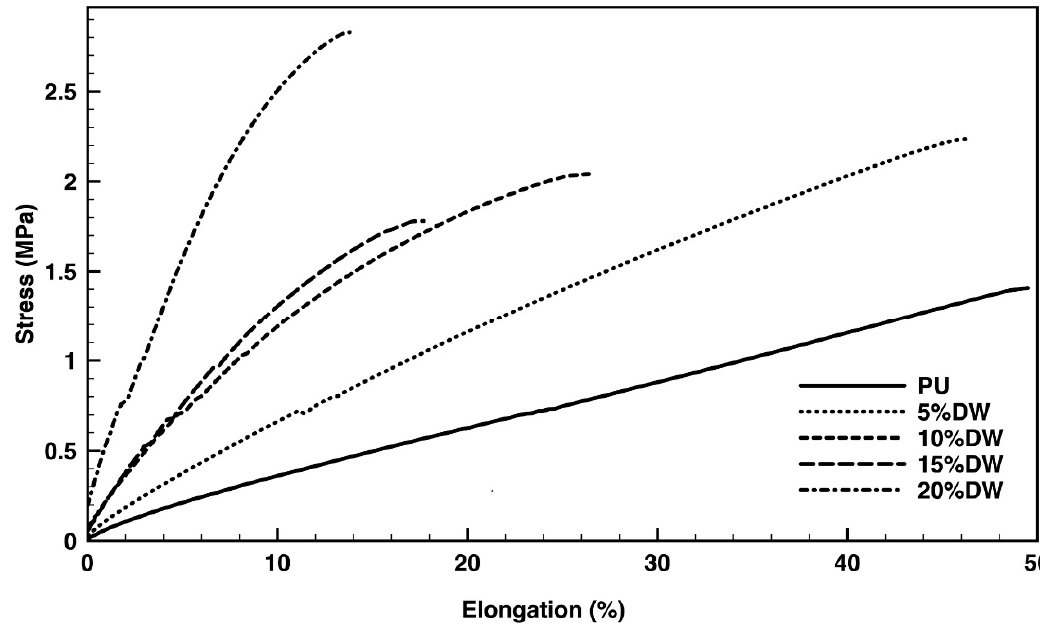
Figure 7. Stress (MPa) versus elongation at break (%) of the pristine PU and the dog wool-reinforced eco-composites.